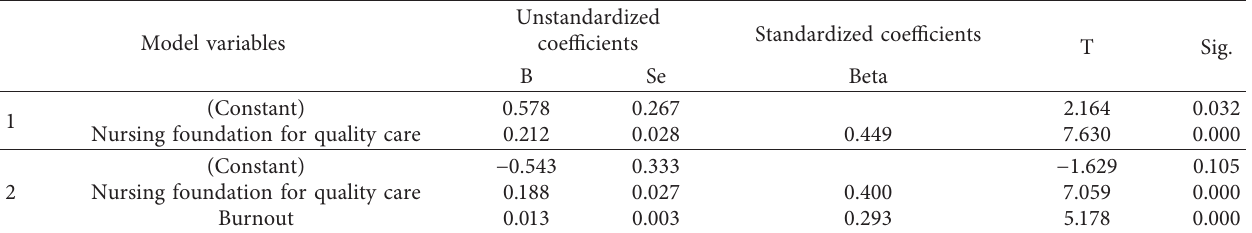
Figure 2: Standardized regression coefficients of the relationship between Nurse Manager’s Leadership Styles and turnover intention as mediated by burnout. Table 3: Mediation effects of burnout on the relationship between nursing foundation for quality care and turnover intention.